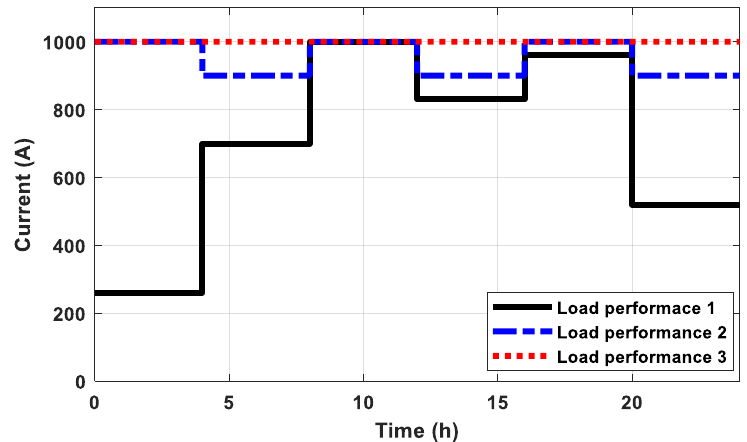
Figure 13. Daily load cycle and step load performance.